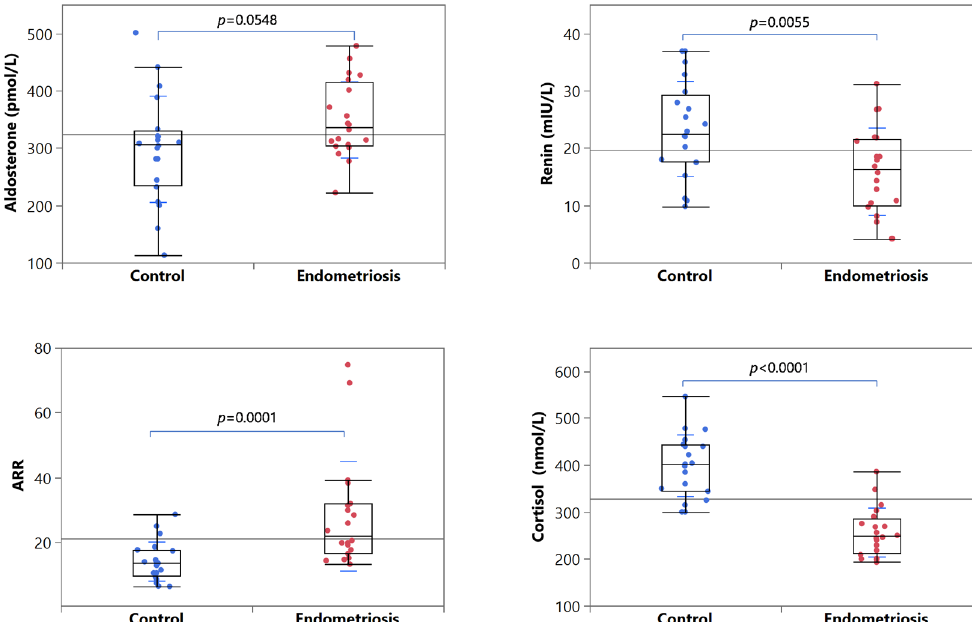
Figure 2. Distribution of aldosterone, renin, ARR, and cortisol values among healthy controls and patients with endometriosis. The edges of the boxes indicate the 25th and 75th quantiles, including the middle 50 percent of the data; the whiskers represent the range of data, calculated as (upper quartile + 1.5 × IQR) and (lower quartile − 1.5 × IQR). The continuous horizontal line is the overall arithmetic mean of the whole data set.